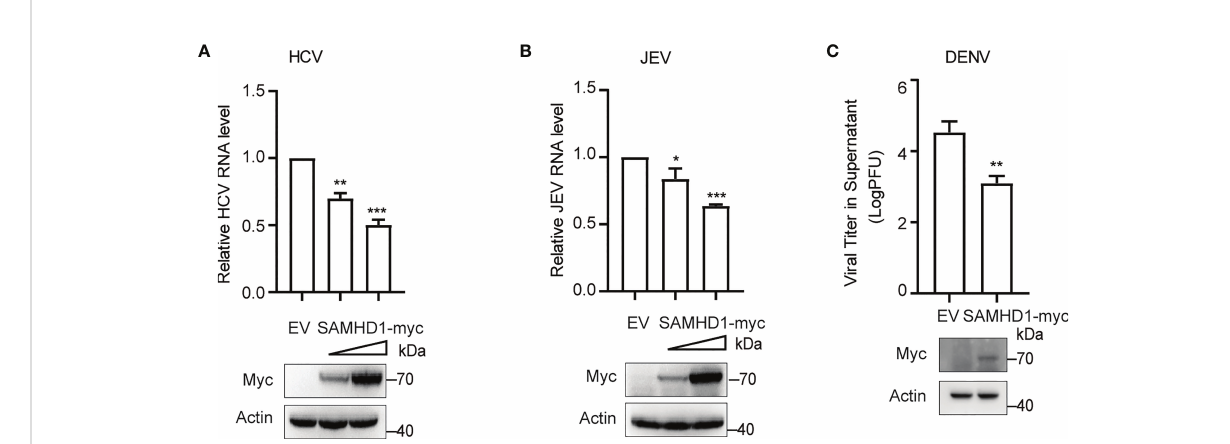
FIGURE 2 SAMHD1 inhibits the fl avivirus infection. Normal Huh7.5.1 cells were transfected with plasmid encoding N-terminal myc-tagged SAMHD1 or pcDNA4.0 for 24 h followed by infection with (A) JFH1 HCVcc (MOI = 0.2), (B) JEV (MOI = 0.2), and (C) DENV (MOI = 0.2), respectively. At 48 hpi, total cellular RNA was isolated by using Trizol reagent for qRT-PCR analysis. HCV and JEV infection levels were evaluated by viral RNA in cells, and viral titer analysis was used for measurement of DENV infection level. Cell lysates were analyzed by Western blotting to determine expression levels of SAMHD1 and b -actin proteins. Data are shown as mean ± SD and depicted as histogram representative of three independent experiments. *P<0.05; **P<0.01, and